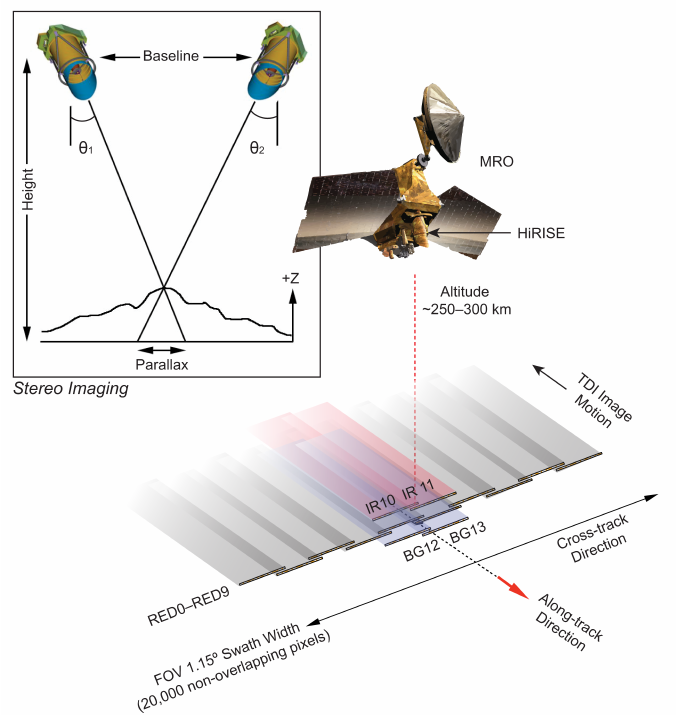
Figure 1. HiRISE focal plane layout schematic projected onto the ground for a nadir imaging scenario (not to scale). Inset illustrates stereo imaging, where MRO rolls perpendicular to the along-track direction to point HiRISE at the target on different orbits. Emission angles are θ 1 and θ 2 , shown here as opposite side roll